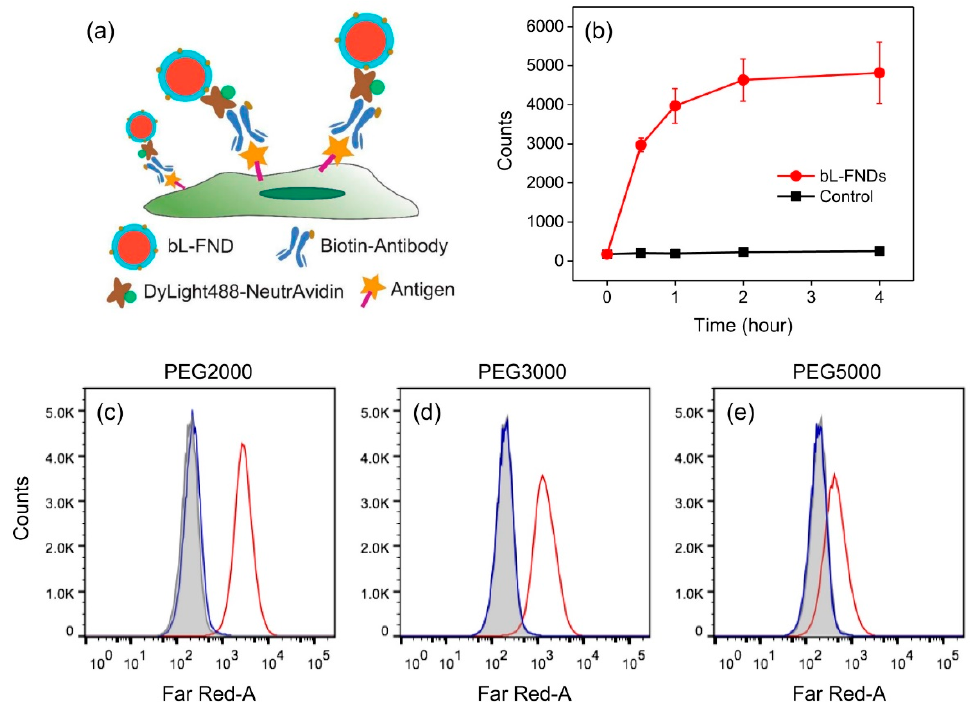
Figure 2. ( a ) Sandwich immunostaining of HeLa cells with bL-FNDs. ( b ) Flow cytometric analysis of fixed HeLa cells labeled with 100 nm bL-FNDs at various incubation times. Control experiments were performed following the same labeling procedures as in (a) but without NeutrAvidin. Error bars represent standard deviations of the measurements in triplicate. ( c – e ) E ff ects of PEG length on the labeling e ffi ciency of bL-FNDs for HeLa cells: PEG2000 (c), PEG3000 (d), and PEG5000 (e). The bL-FND concentrations used in the labeling were all 100 µ g / mL. Control experiments were performed with HeLa cells only (grey areas), or following the same labeling procedures but without NeutrAvidin (blue curves).